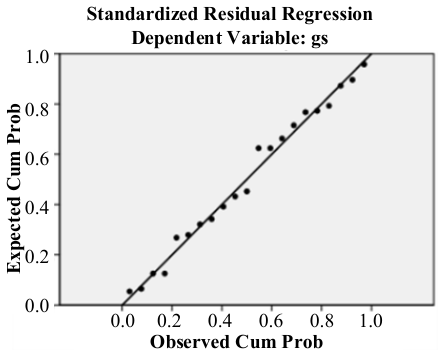
Figure 13. Normal P–P plot between the observed cumulative probability and expected cumula- tive probability.